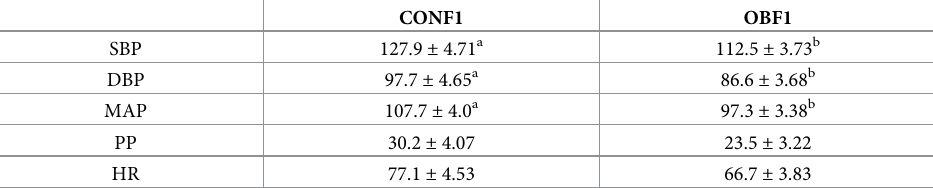
Table 2. Aged F1 ewe invasive blood pressure. Measurements for CONF1 (n = 5) and OBF1 (n = 8) ewes at 9 years of age: Treatment analysis results.